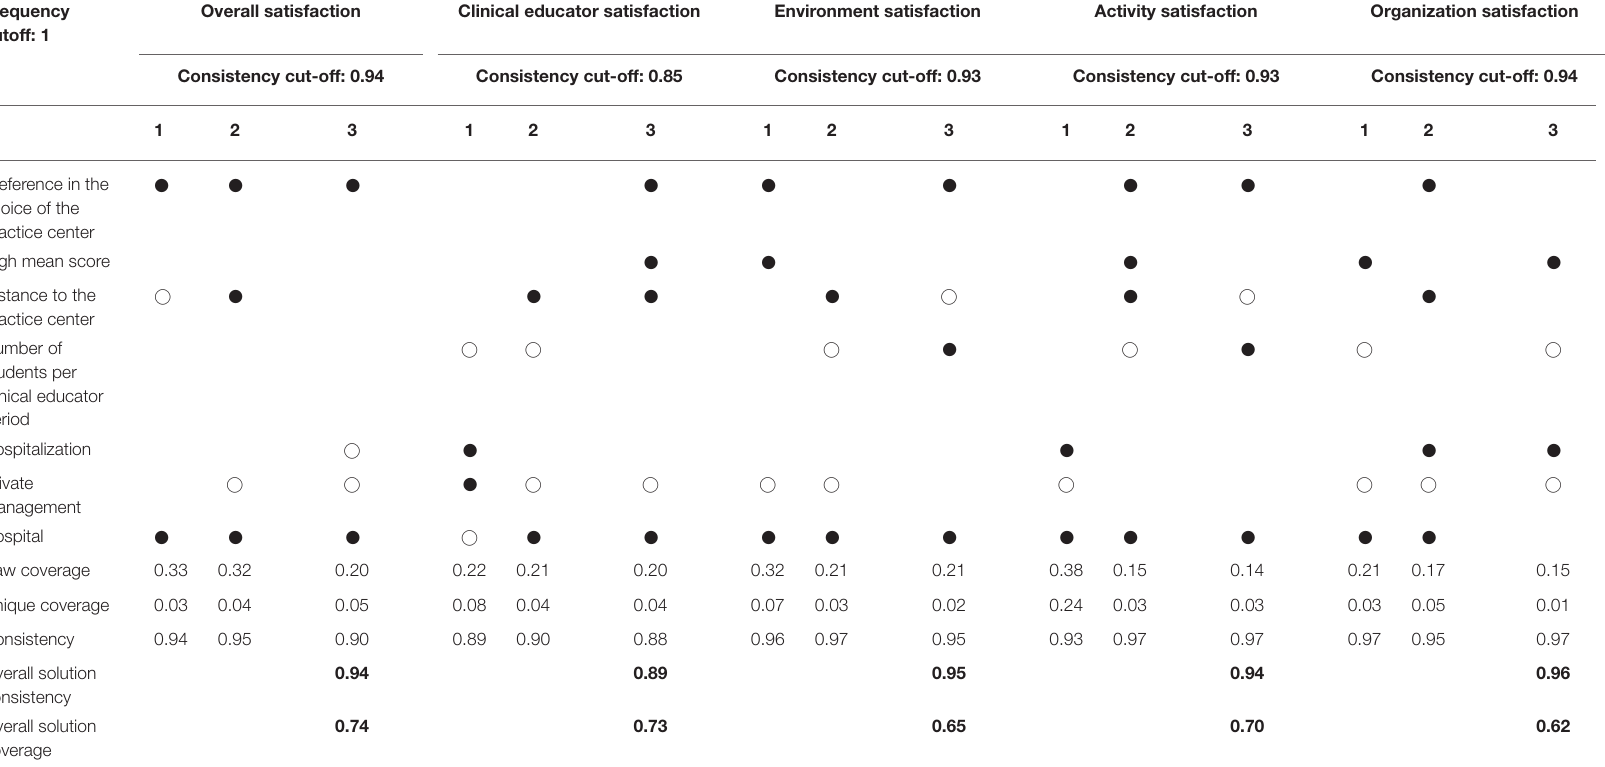
TABLE 5 | Summary of the three main sufficient conditions for the intermediate solution of satisfaction. Frequency cutoff: 1